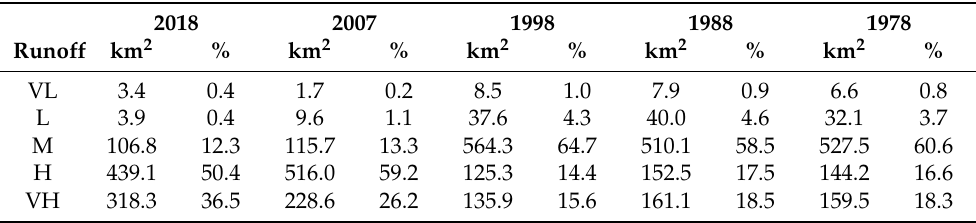
Figure 8. Surface runoff computed using NRCS-CN method for the catchment area. Table 9. Decadal runoff classes with inundation area (km 2 ) and percentage (%) respect to the catchment area.